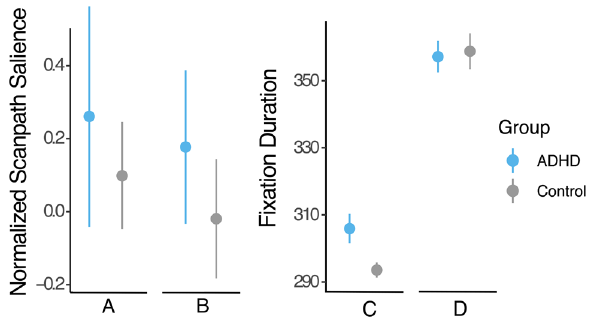
Figure 4. The left panel represents normalized scan path saliency averaged by Condition. ( A ) Task Scenarios without distractors, ( B ) Task Scenarios with distractors. The right panel shows fixation durations to different types of objects. ( C ) Task-irrelevant objects, ( D ) Task-relevant objects.